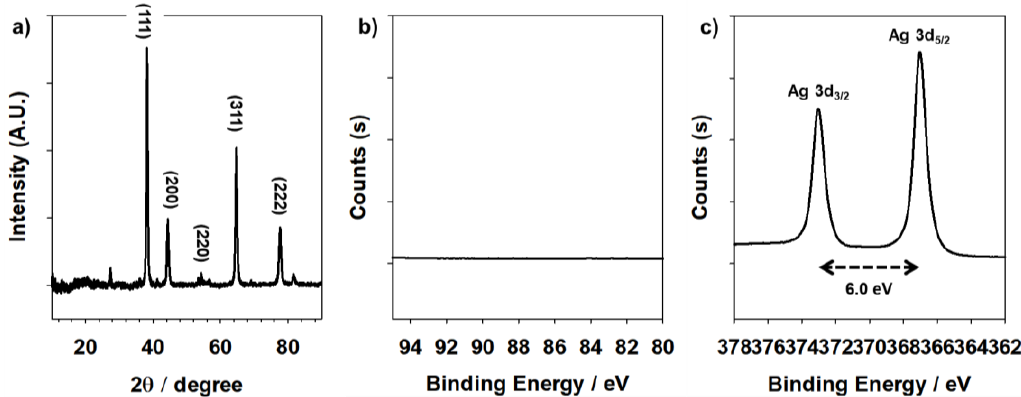
Figure 4. Structural and surface element analysis of SMPs3. ( a ) XRD spectrum of SMPs3. High resolution ( b ) Au 4f and ( c ) Ag 3d XPS spectra of SMPs3.